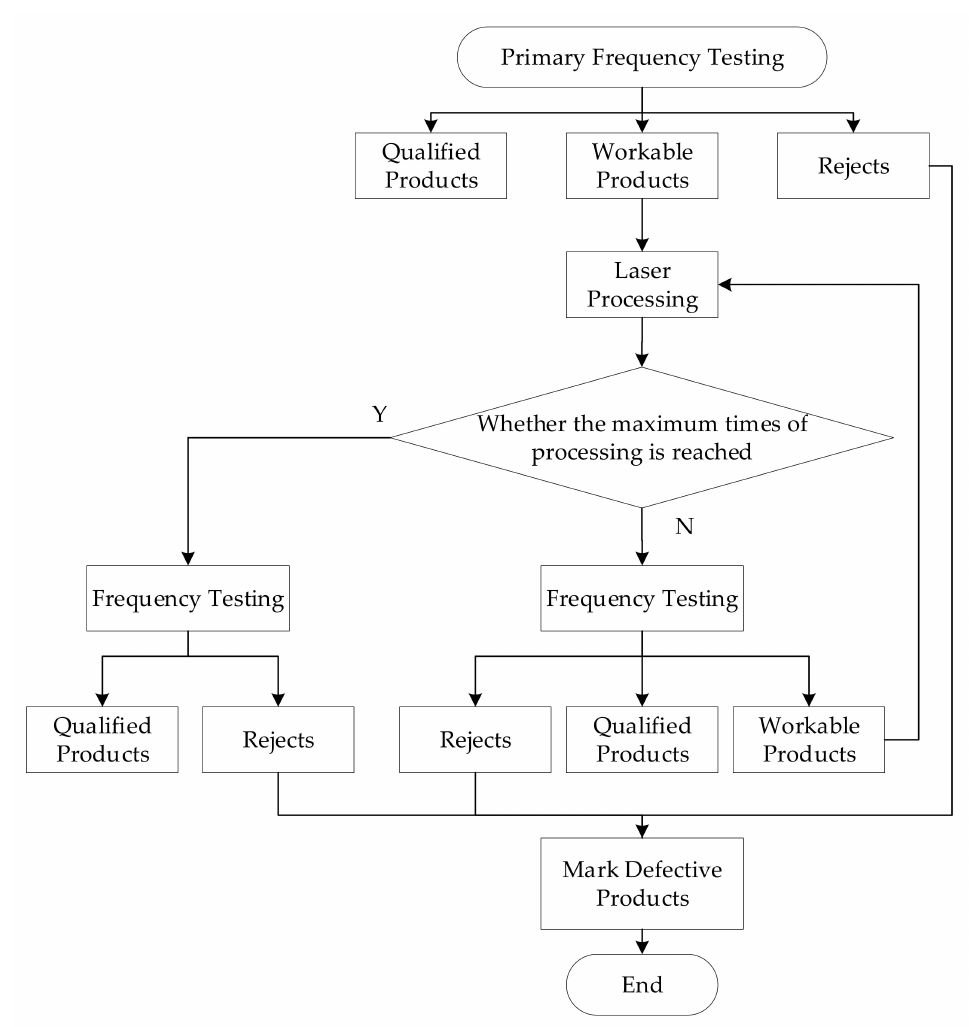
Figure 4. Frequency modulation flow